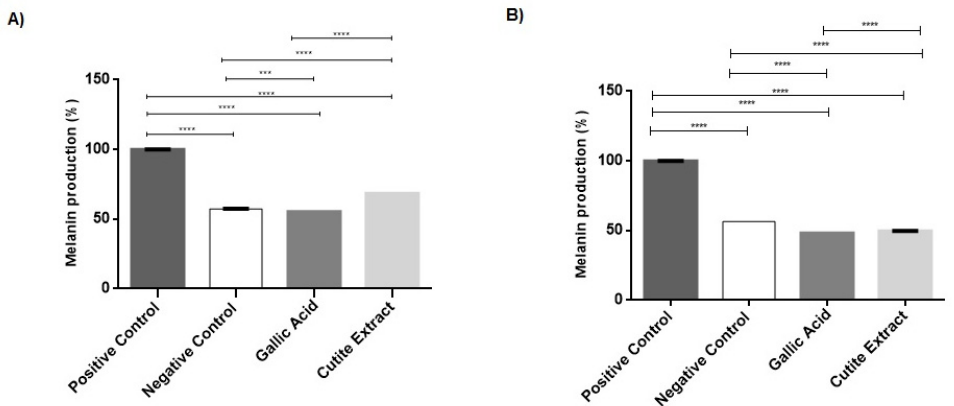
Figure 2. Melanocyte pigmentation was analyzed compared to IBMX-stimulated cells (positive con- trol) and untreated cells (negative control). Intracellular melanin ( A ) production produced by B16F10 cells as well as melanin secretion in culture supernatant ( B ) after treatment with gallic acid and extract for 48 h, stored in an oven, were measured. Each bar represents an average of 3 deter- minations ± SD. *** p < 0.001; **** p <